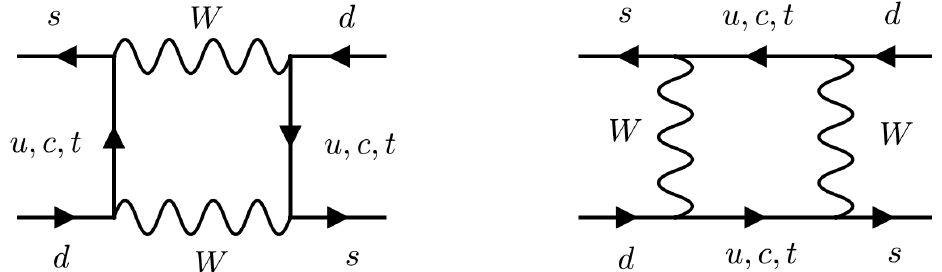
Figure 1 . Box diagrams describing K 0 − ¯ K 0